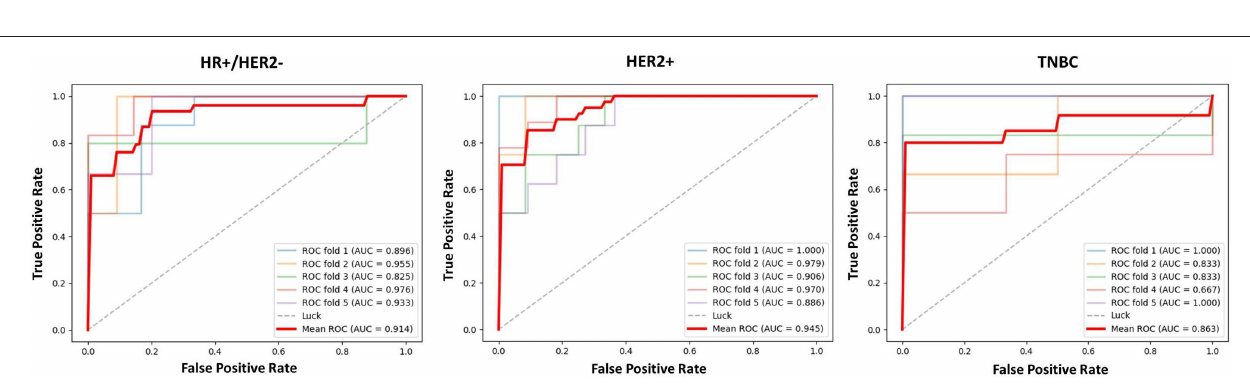
FIGURE 5 | The ROC curves of prediction model based on three molecular subtypes in testing dataset for 1-round